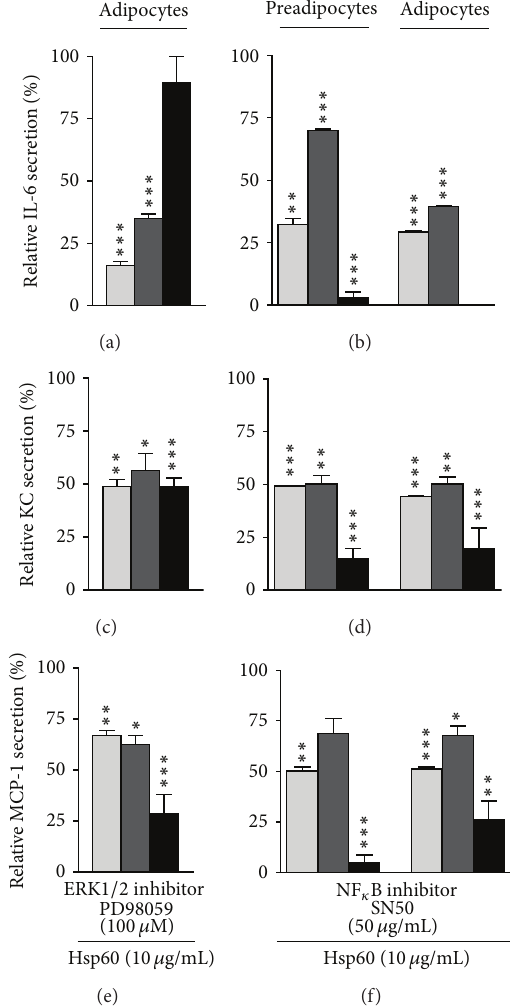
Figure 6: Characterization of signaling pathways involved in Hsp60-mediated release of inflammatory mediators from C57BL/6J, NOD, and NZO mouse-derived (pre-)adipocytes. Cells from C57BL/6J (light grey bars), NOD (dark grey bars), and NZO mice (black bars) were exposed to Hsp60 after preincubation (1h) with specific inhibitors against the MAP-kinase ERK1/2 (PD98059) (a, c, e) and NF 𝜅 B (SN50) (b, d, f). After 24h, IL-6 (a, b), KC (c, d), and MCP-1 (e, f) concentrations were determined in the culture supernatants by multiplex-beads-assay. The results show residual cytokine levels in percent of the cytokine concentrations released from cells incubated in the absence of Hsp60. Data show means + SEM from three to six experiments for each inhibitor. ∗ 𝑃 < 0.05 , ∗∗ 𝑃 < 0.01 , ∗∗∗ 𝑃 < 0.001 compared to incubation with Hsp60 alone set as